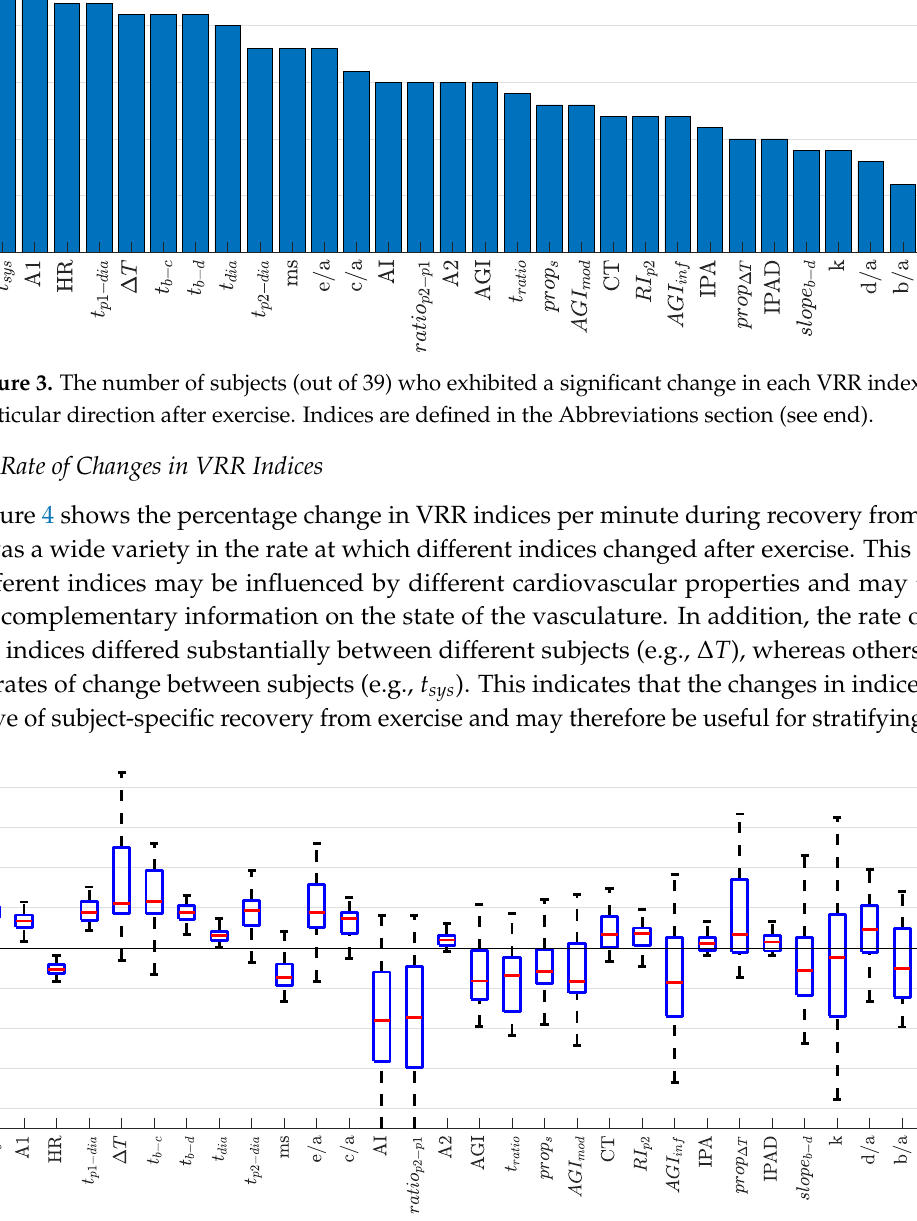
Figure 4. The distributions of the percentage change in each VRR index per minute during recovery from exercise. Boxplots show the median, lower, and upper